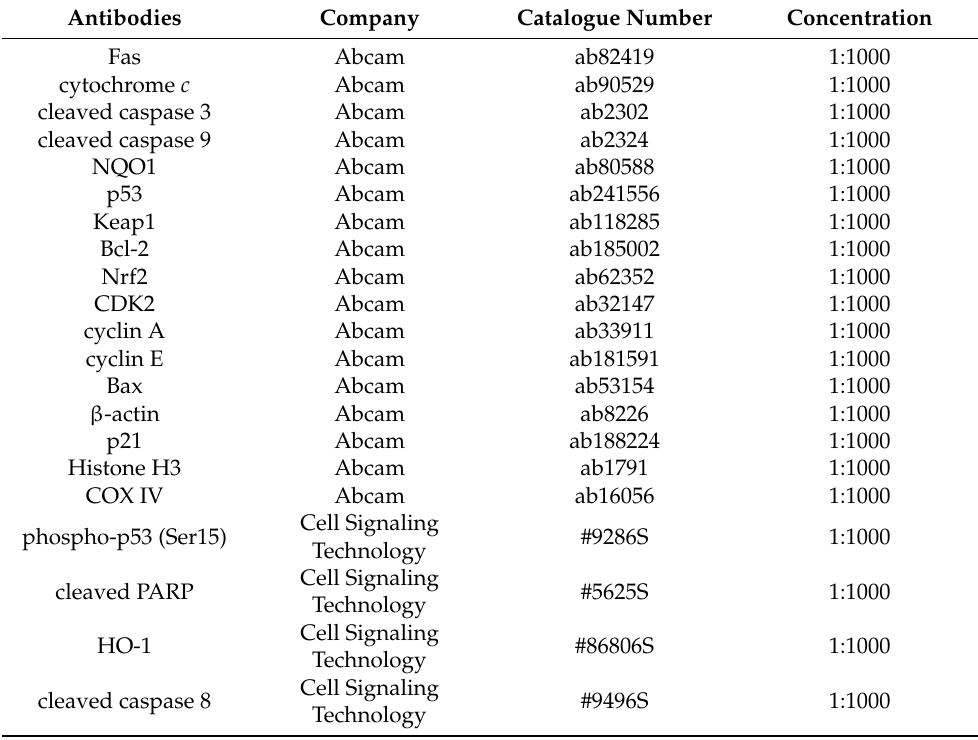
Table 1. All antibodies used in the study are listed